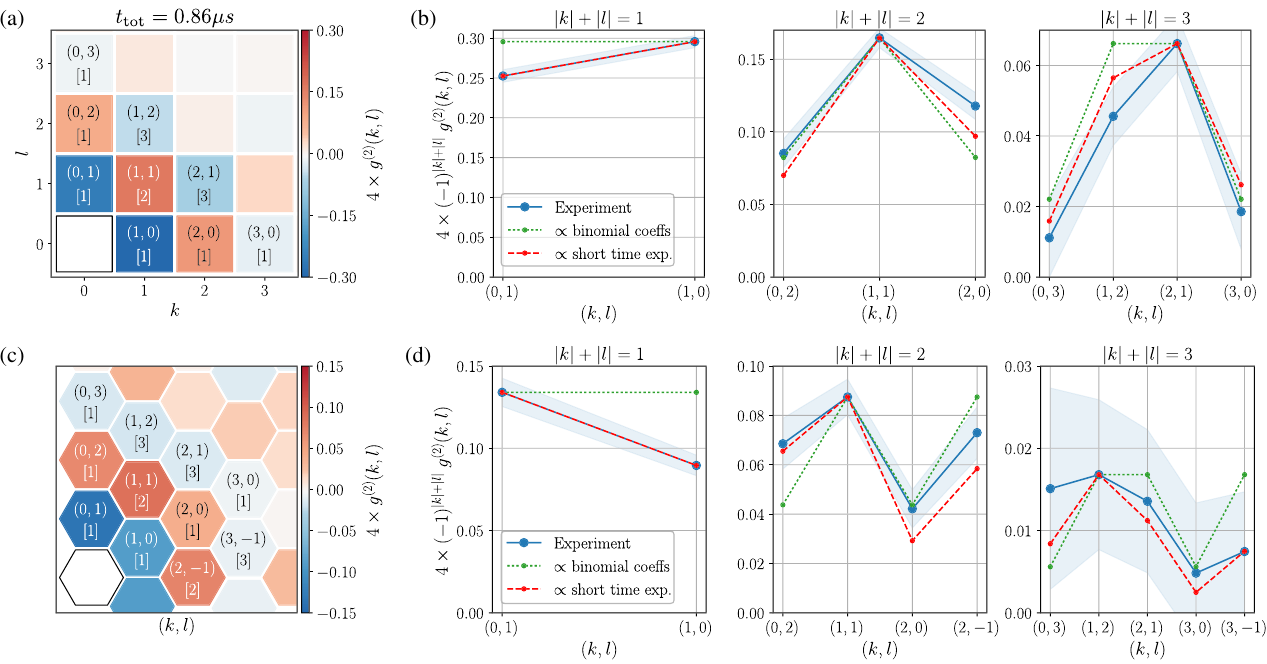
FIG. 5. Spatial structure of the spin-spin correlations on the 36-site square (a),(b) and on the 36-site triangular lattice (c),(d). Experimental data after a sweep is shown in (a) and (c), together with the values of ð k; l Þ for the first three shells j k j þ j l j [see Fig. 1(d) for the full range]. The numbers in brackets [ c ] give the number of linking paths contributing to the short-time expansion. (b) and (d) Dependence of the correlation on ð k; l Þ for several Manhattan distances with a qualitative comparison to binomial coefficients (green dotted lines) and leading-order short-time expansion (red dashed lines); see text for details. The shaded region corresponds to the s.e.m. of the experimental